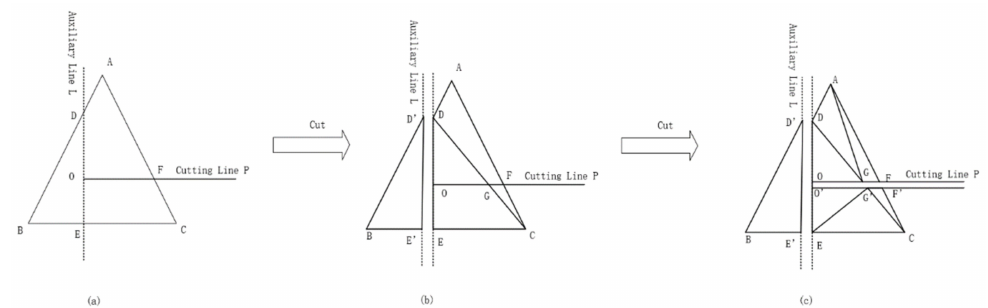
Figure 9. Triangle clipping method 3. ( a ) Triangle before cutting. ( b ) Triangle cut by an auxiliary line. ( c ) Triangle cut by an auxiliary line and a cutting